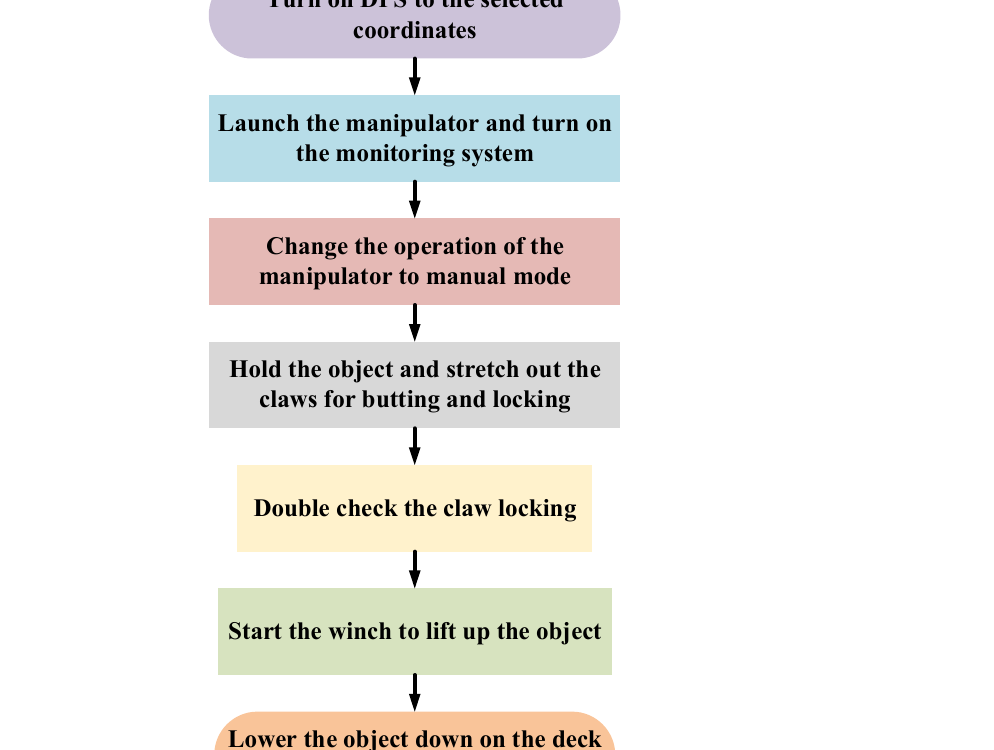
Figure 12. Flowchart of the manipulator operation process.